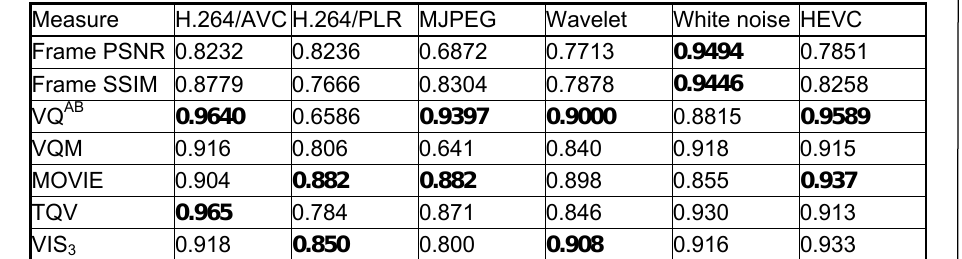
Table 7 – Spearman rank-order correlation coefficient (SROCC) between subjective and objective quality scores on the CSIQ Video